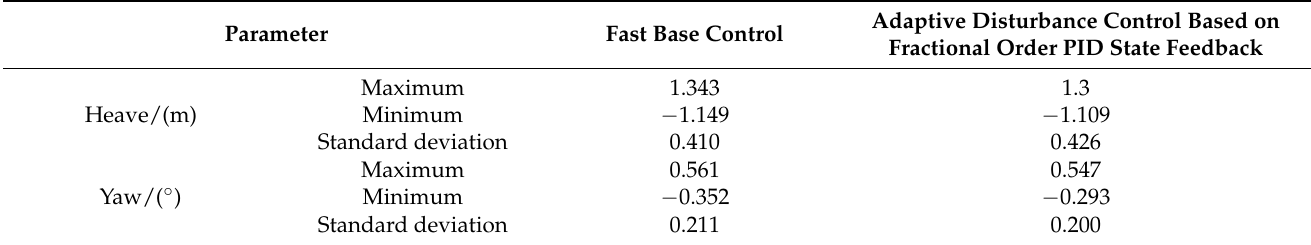
Figure 14. Comparison of yaw angles under two different control algorithms. Table 6. Comparison of heave displacement and yaw angle between two control